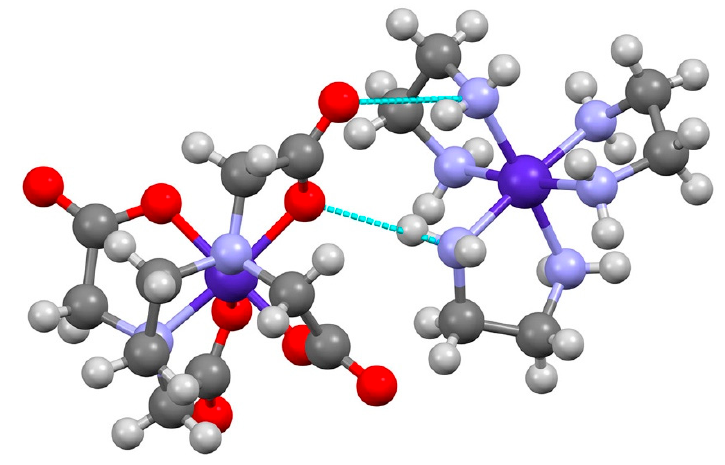
Figure 5. Hydrogen bonding between Λ -[Co(en) 3 ] 3+ and ∆ -[Co(edta)] − with a Co-Co distance of 5.844 (1) Å. The view is roughly down the molecular C 3 -axis of Λ -[Co(en) 3 ] 3+ and shows the Λ ( λ , λ , λ ) ( ob 3 ) conformation. Bond distances for complexes (Å): Co-N ( Λ - [Co(en) 3 ] 3+ ) 1.955(2), 1.965(2), 1.960(3); Co-N ( ∆ -[Co(edta)] − ) 1.921(3), 1.927(2); Co-O (G-ring) 1.914(2), 1.921(3); Co-O (R-ring) 1.888(2), 1.877(2).